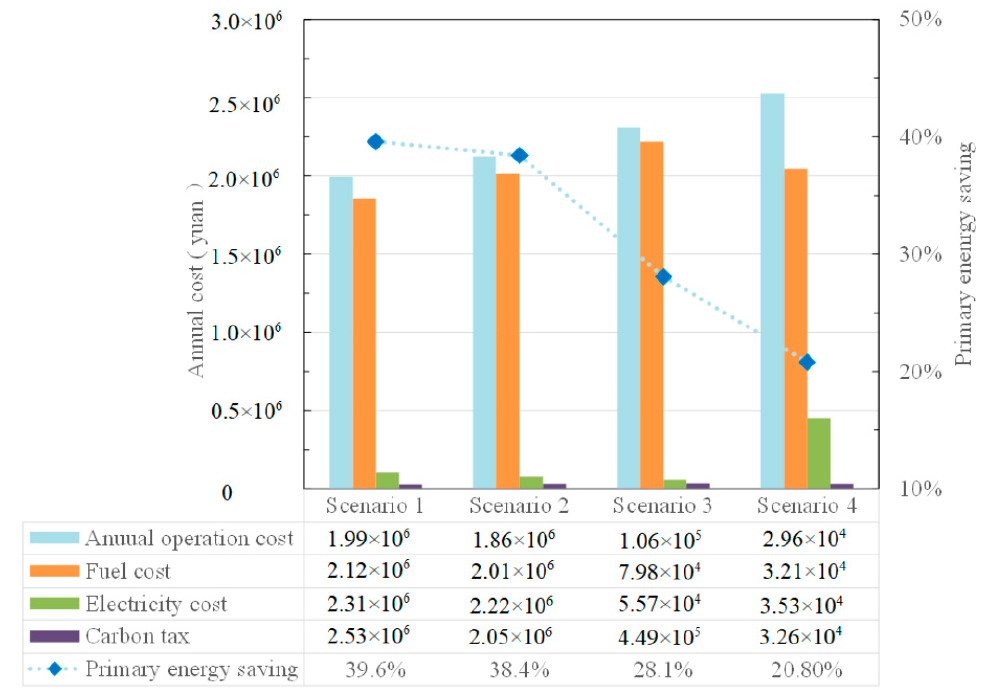
Figure 6. Economic and environmental results in different scenarios.